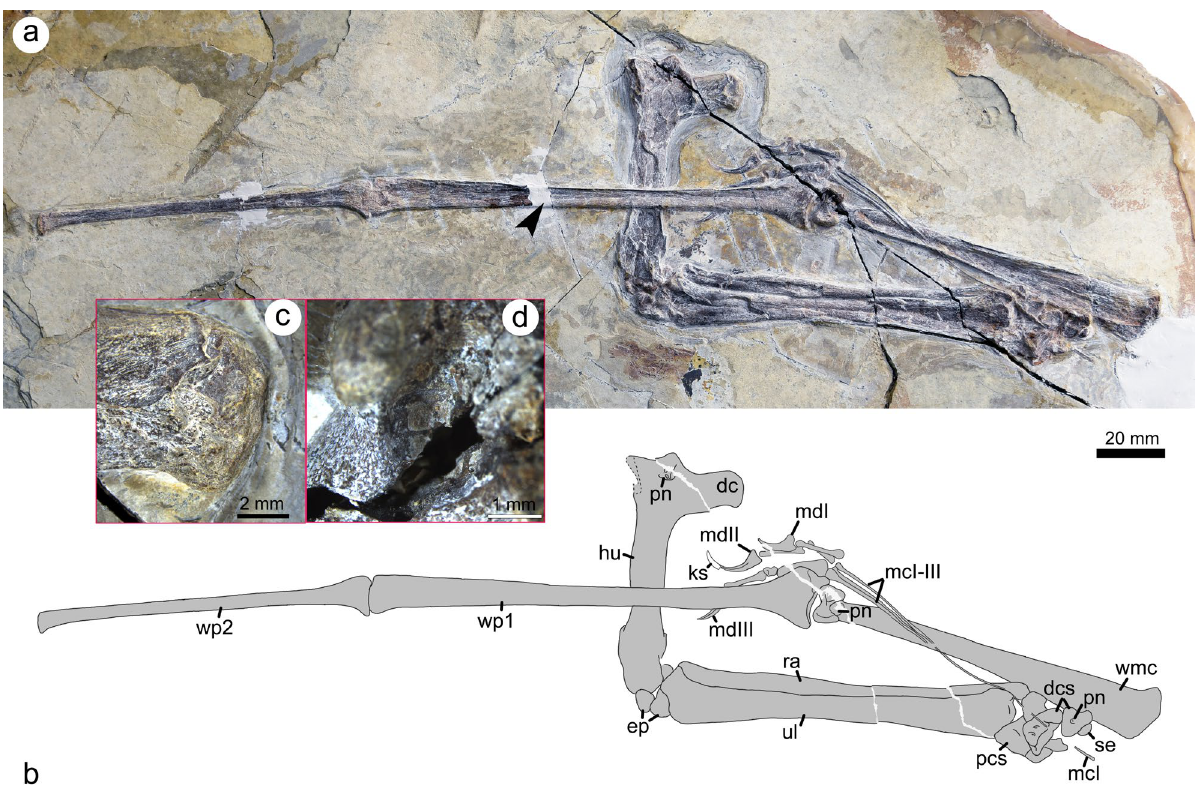
of the wing metacarpal ( d ). Arrow points to the thin-section sample position on the first wing phalanx. dc deltopectoral crest, dcs distal carpals, ep unfused epiphyses, hu humerus, ks keratinous sheath of the second manual digit ungual, mcI metacarpal I, mcI-III metacarpals I–III, md I manual digit I, md II manual digit II, mdIII manual digit III, pcs proximal carpals, pn pneumatic foramen, ra radius, se carpal sesamoid, ul ulna,